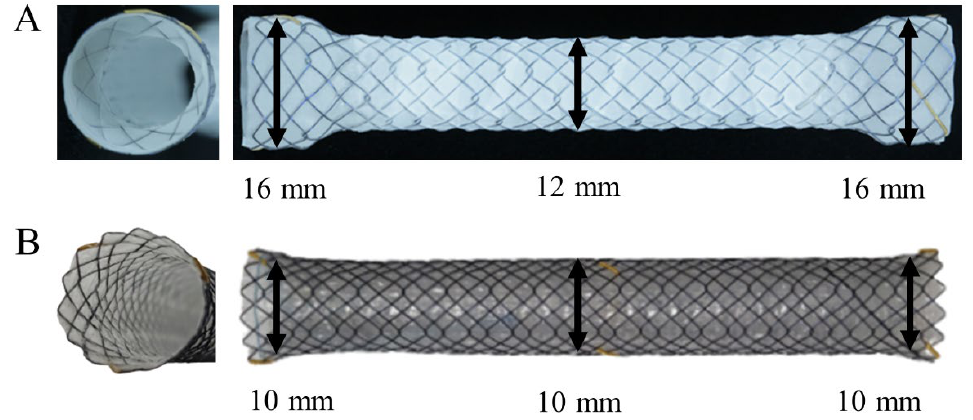
Figure 1. Structure of FCSEMSs. ( A ) A FCSEMS-L (Hilzo Biliary Stent ® ; BCM Ltd., Seoul, Korea) has a 12-mm body diameter and 16-mm head diameter, with dumbbell-shaped ends. ( B ) A FCSEMS-C (Hanaro Biliary Stent ® ; M.I. Tech, Seoul, Korea) has a 10-mm-diameter head and body.